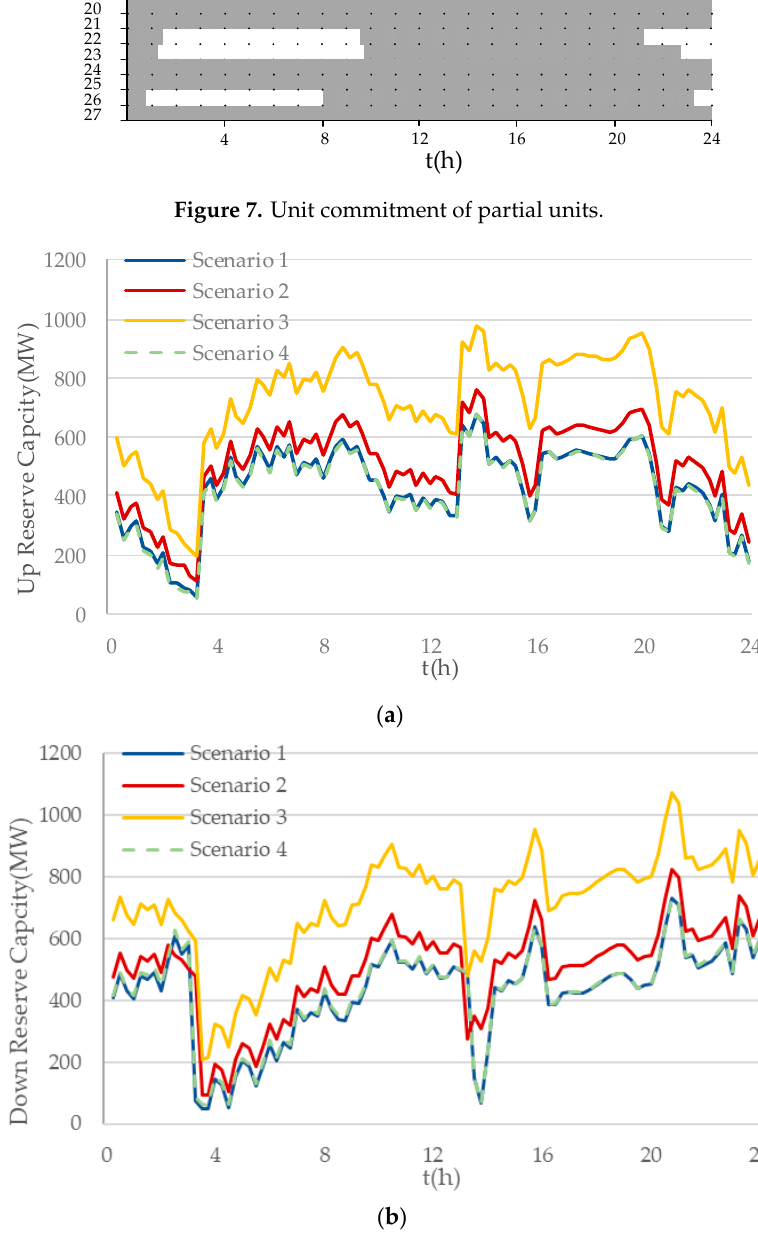
Figure 8. Comparison of reserve in different scenarios. ( a ) Comparison of the up reserve; ( b ) comparison of the down reserve.